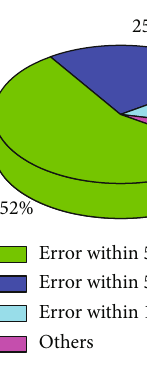
Figure 13: Pie chart of predicted error distribution in this